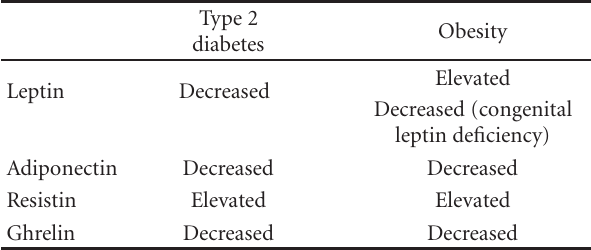
Table 2: Hormonal modifications in type 2 diabetes and